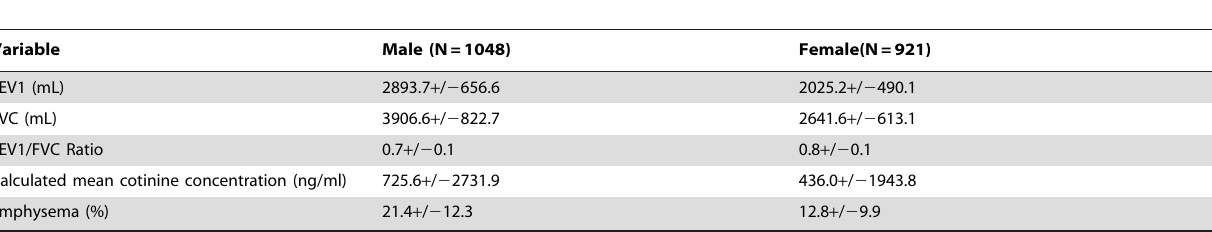
Table 4. Mean spirometry, urine cotinine, and percent emphysema values, stratified by